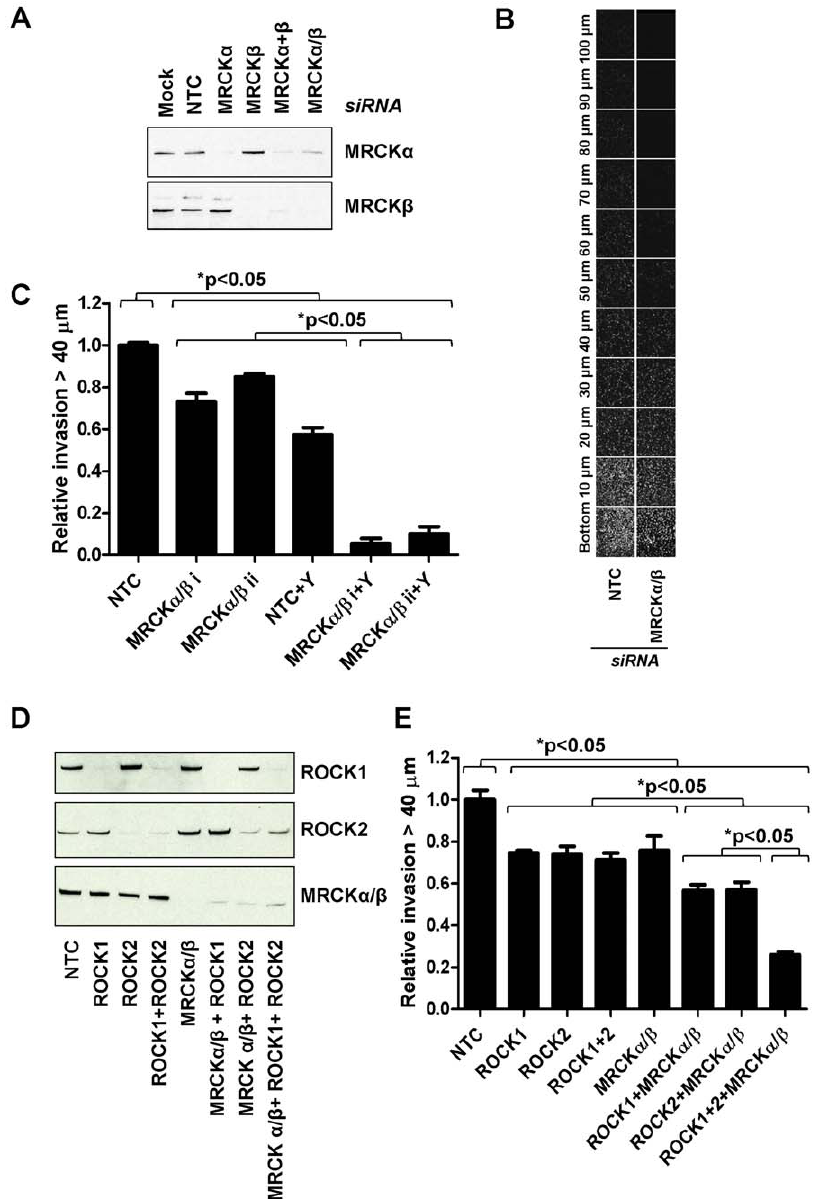
Figure 1. Inhibition of 3-D matrigel invasion by MDA MB 231 cells following MRCK and ROCK inhibition. ( A ) Knock-down of MRCK a and MRCK b individually or in combination. Double knockdown was achieved either by combining separate siRNAs (MRCK a + b ) or single siRNA duplexes that target both kinases (MRCK a / b ). NTC=non-targeting control. ( B ) Optical slices were obtained every 10 m m by confocal imaging. ( C ) Invasion 40 m m above the transwell filter surface was normalized to non-targeting control (NTC) siRNA transfected cells. Significant differences between groups of columns indicated. (Average 6 SEM, n=3). MRCK a / b knockdown or ROCK inhibition with Y-27632 (Y) significantly decreased invasion, with the combination of MRCK a / b knockdown and ROCK inhibition resulting in significantly more inhibition. ( D ) Effectiveness and specificity of ROCK1, ROCK2 and MRCK ab knockdowns. ( E ) The combination of MRCK a / b with ROCK1 and ROCK2 knockdown individually or in combinations were tested for their effects on 3-D matrigel invasion. ROCK1, ROCK2 or ROCK1 + ROCK2 combination were able to significantly inhibit invasion. However, additional MRCK a / b knockdown significantly increased the inhibition of invasion in each instance. (Average 6 SEM, n=3).